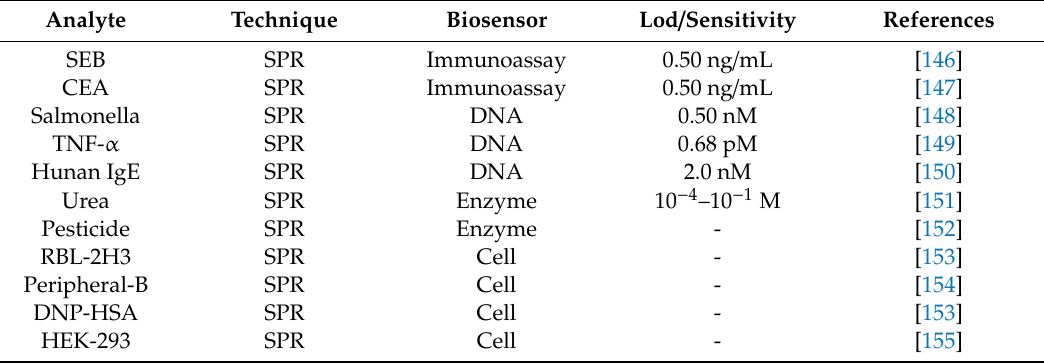
Table 9. List of applications of the fibre-optic SPR